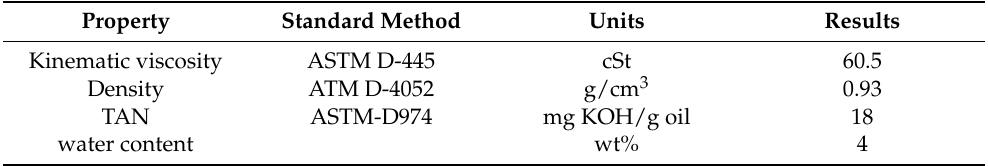
Table 2. Physicochemical properties of the feedstock.